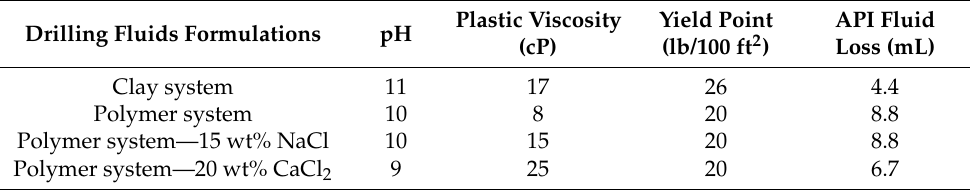
Table 3. Properties of the four drilling